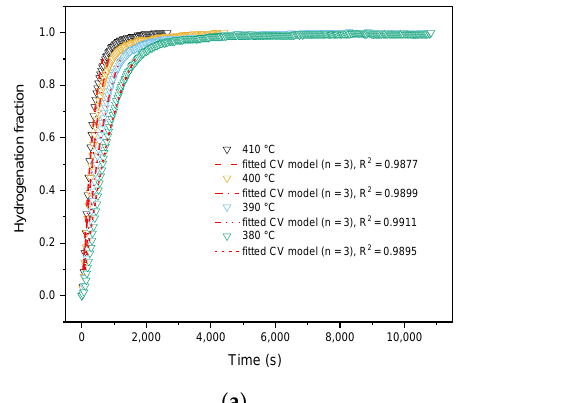
Figure 6. Plots of (t/t 0.5 ) experimental versus (t/t 0.5 ) theoretical for the 2 nd hydrogenation kinetics of the Li-RHC + AlTi 3 sample at 400 °C and under 50 bar of H 2 . The activation energy for the hydrogenation process was determined by fitting the kinetic curves with the selected reaction model. The 2nd hydrogenation kinetic curves of the Li-RHC + AlTi 3 in the range of temperature between 380 ◦ C and 410 ◦ C were fitted with the CV ( n = 3) model. The fitting results and the calculated activation energy for the hydrogenation are presented in Figure 7. As seen in Figure 7a, the measured and the fitted data of the Li-RHC + AlTi 3 sample show a good matching with correlation coefficients R 2 close to 1. A kinetic rate constant ( k ) is obtained from the fitting of each hydrogenation curve (Supplementary Materials ESI-Table S4) for each hydrogenation curve fitted. As seen in Figure 7b, the activation energy of the hydrogenation is about 123 ± 3 kJ/mol H 2 . This value is significantly lower than that of the pristine Li-RHC ( E a = 184 ± 6 kJ/mol H 2 ), and similar to that of the Li-RHC + 3TiCl 3 · AlCl 3 sample ( E a = 124 ± 6 kJ/mol H 2 ) given in [50]. This result indicates that the presence of AlTi 3 nanoparticles changed the rate-limiting step and reduced the activation energy of the hydrogenation process, leading to the faster kinetic properties of the Li-RHC + AlTi 3 compared with the neat Li-RHC system.